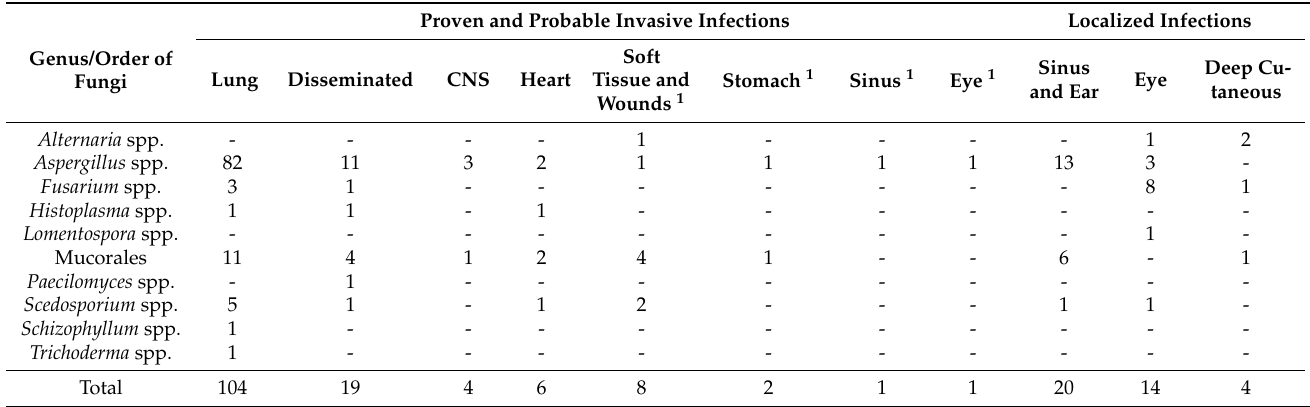
Table 4. Fungal spectrum according to